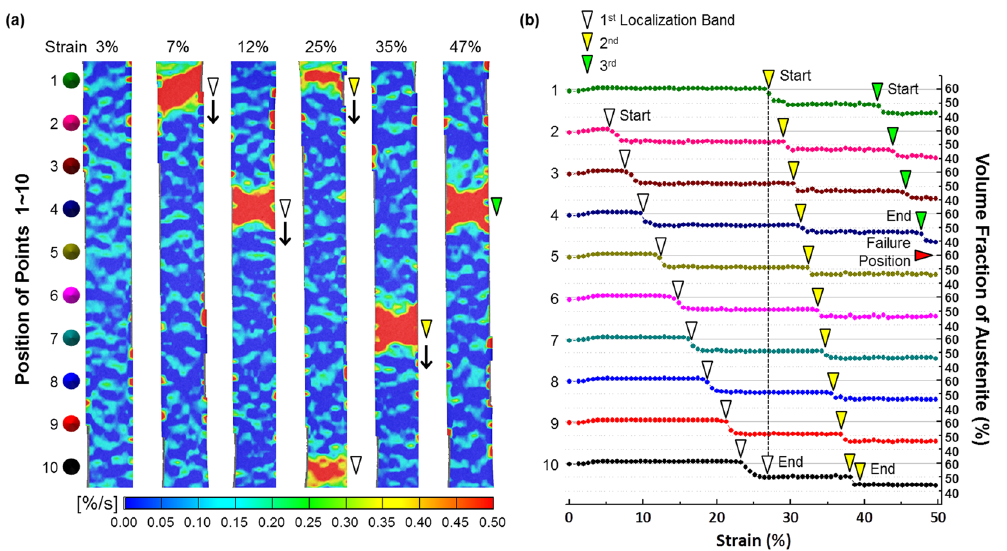
Figure 5. Strain rate distribution and localized martensitic transformation during deformation of the A650 steel. ( a ) Digital images of strain rate in strain range of 3~47% after points ‘1’~‘10’ were marked in the specimen gage section of the A650 steel. Three localized bands are generated, moved downward, and diminished as marked by white, yellow, and green arrows. ( b ) Variations in austenite volume fraction during the generation and movement of localized bands. The martensitic transformation occurs step by step while three localized bands are generated and